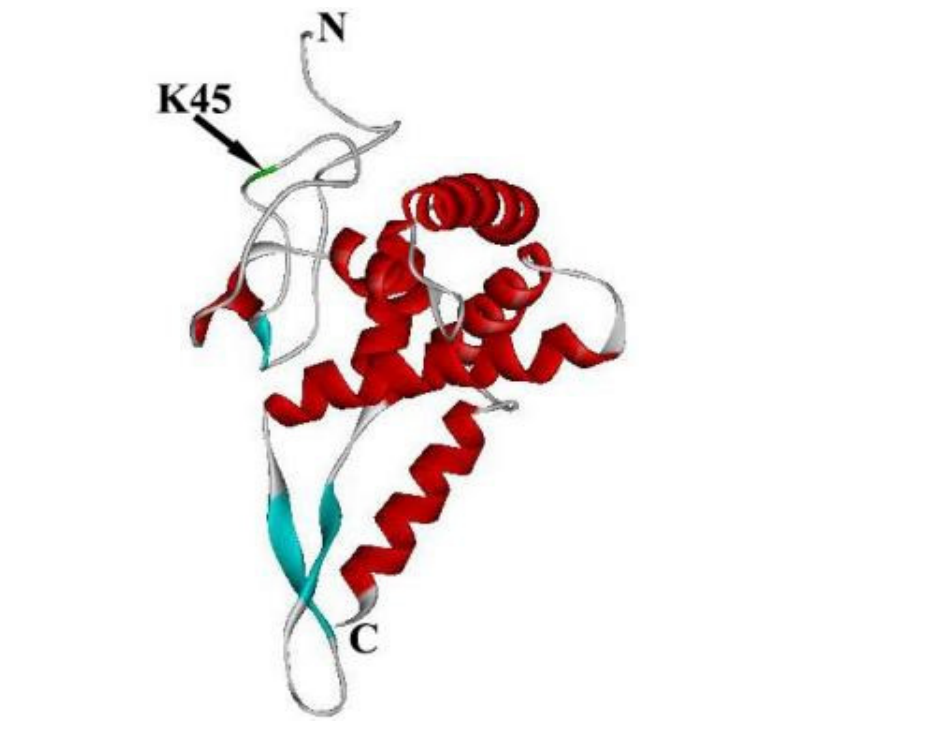
Figure 5. Crystal structure of Homo RPS5 is separated from the structure of Homo 40S using software of chimera. The green domain is K45.